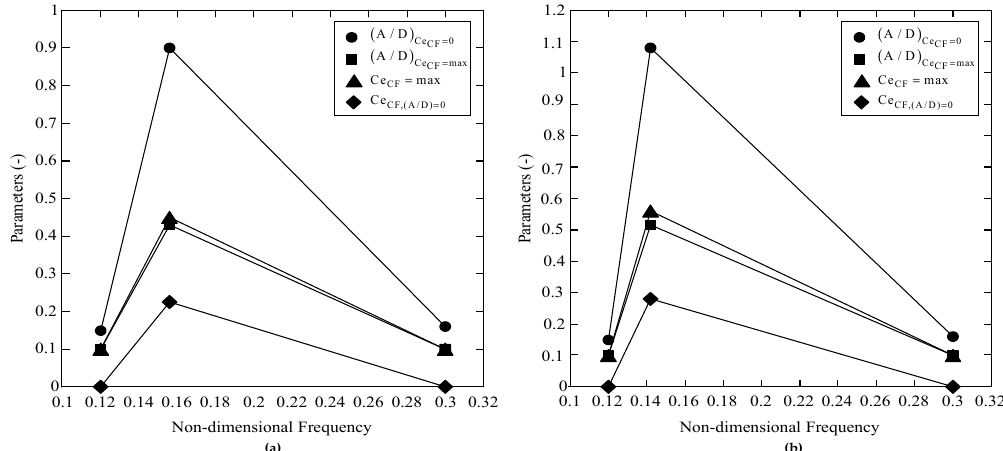
Figure 11. The optimal excitation parameter set for 2 / 2 configuration at 1.0 m / s flow speed for ( a ) bare part of the riser; ( b ) buoyancy section of the riser.